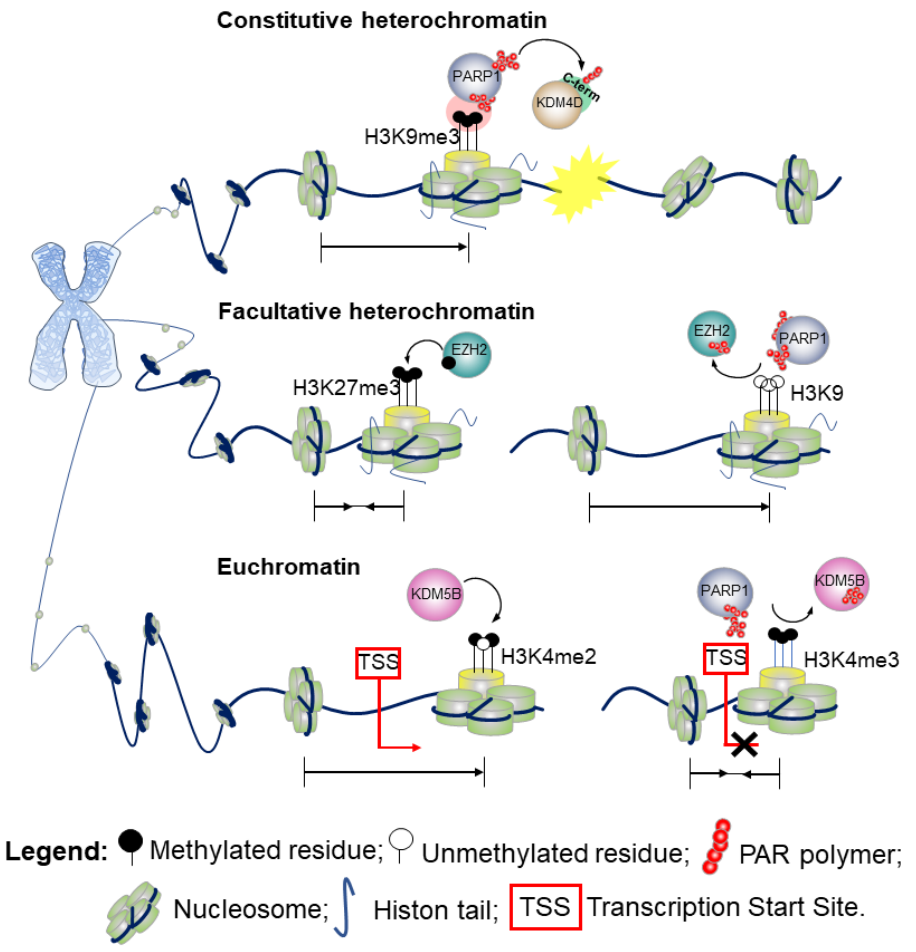
Figure 4. PARP1 plays a role in chromatin modifications : euchromatin, constitutive heterochro- matin, and facultative heterochromatin.